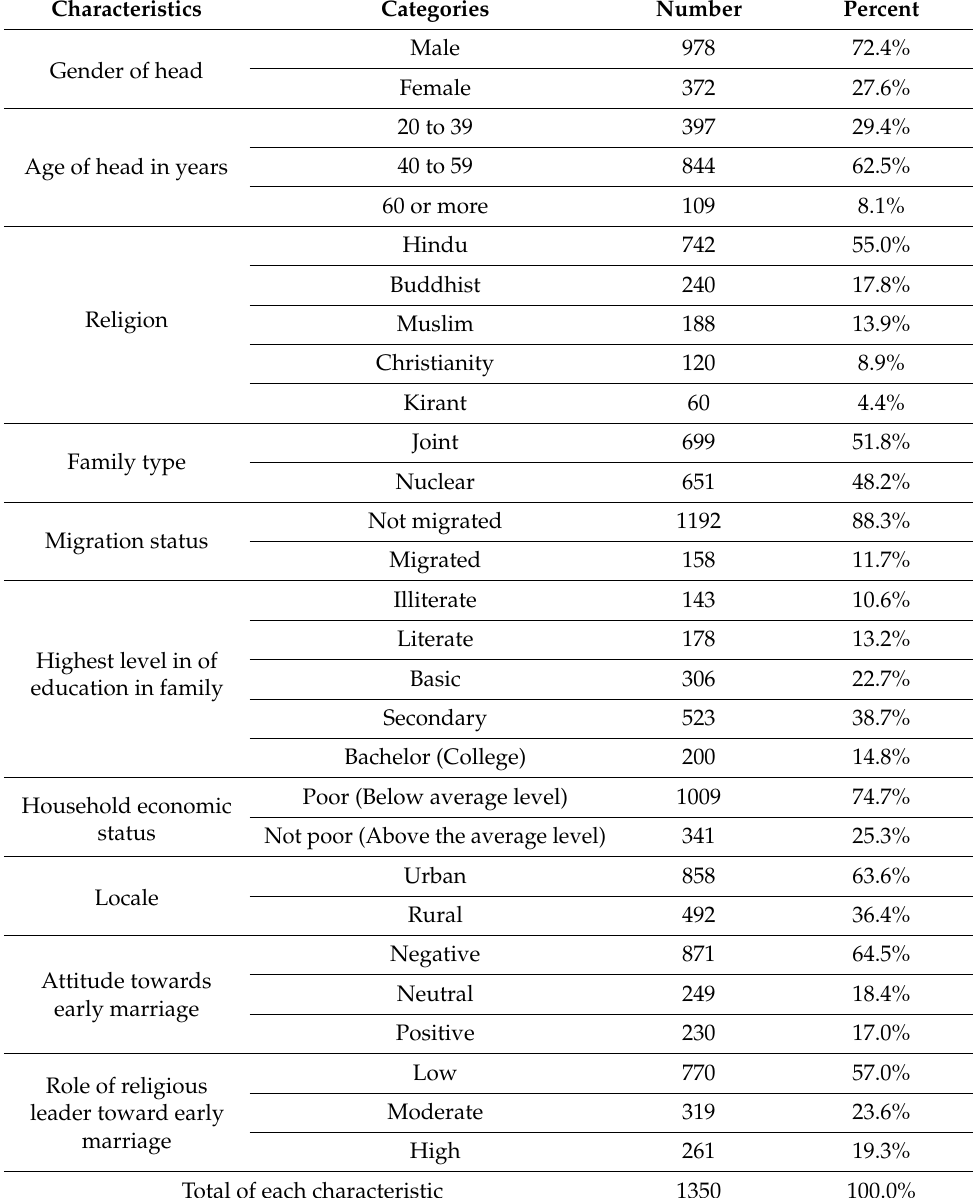
Table 1. Sample Descriptive